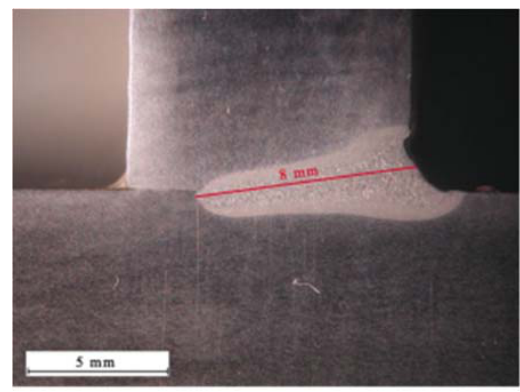
Figure 5. Maximum penetration during single ‐ sided welding.